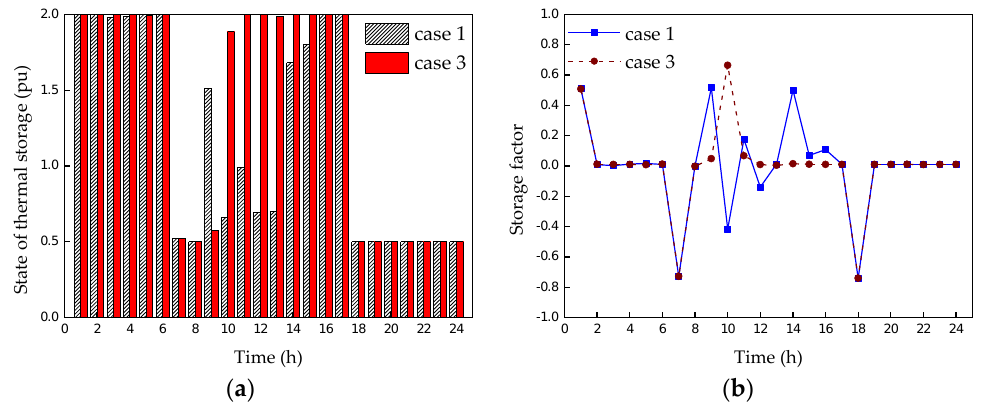
Figure 11. Heat storage operation result: ( a ) State of thermal storage; ( b ) storage factor.